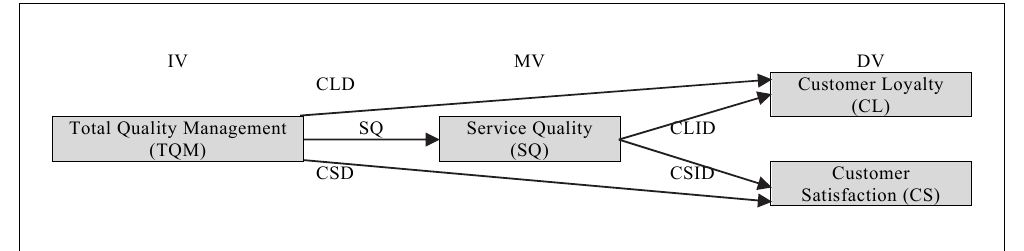
Fig. 1. Theoretical Framework. Adopted from Hair et al. (2010) and Brown